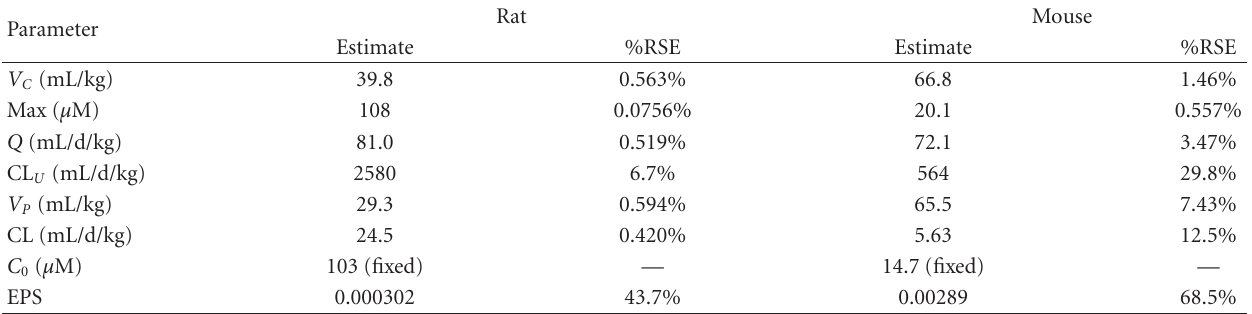
Table 1: Summary of the cuto ff PK model parameter estimates in rats and mice based on the PK data simulated by using Hansen’s PK models.